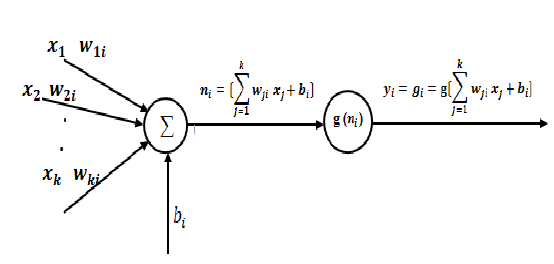
Fig. 7. The single node of the